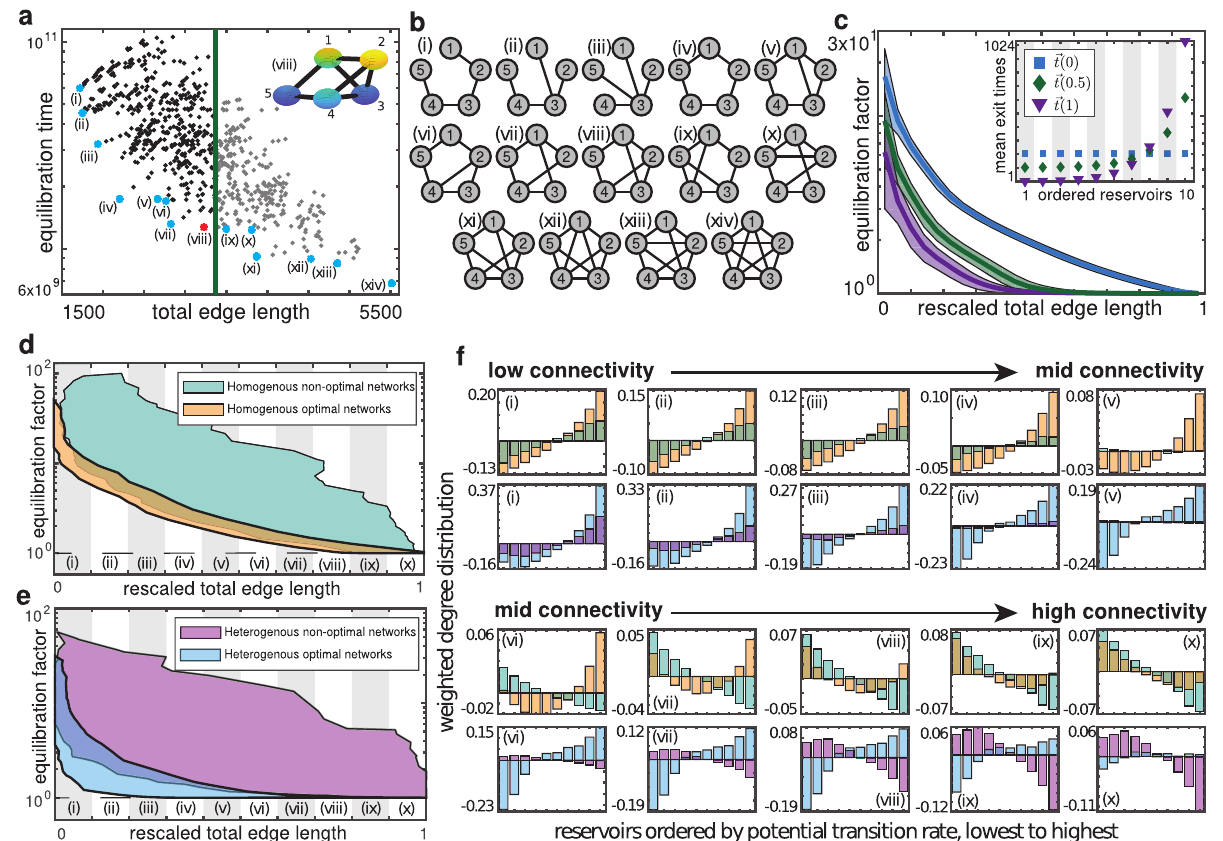
Fig. 3 Optimal topologies that minimise networked equilibration times. a Equilibration time and total edge length for all 728 connected topologies for a con fi guration of fi ve reservoirs (inset). The reservoir colours represent the change in elevation highlighting how they are positioned in three-dimensional space. The optimal frontier is highlighted in asterisks and given labels (i) – (xiv). For a given restriction (vertical line) the optimal network is given by label (viii) and the asterisk is red. b Topologies of the networks that lie on the optimal frontier in panel ( a ). c Averaged coordinates from numerically estimated optimal frontiers (Supplementary Note 4) with increasing levels of reservoir heterogeneity. The vectors of reservoir mean exit times are t (0), t (0.5) and t (1) (inset). The shaded regions represent the standard deviation either side of the mean. d The range of equilibration factors of both optimal and non- optimal networks for homogeneous, t (0), and heterogeneous, t (1), reservoir geometries. The shaded regions outlines the boundary of a point cloud from 5000 different con fi gurations of 10 reservoirs (Supplementary Note 4), both optimal and non-optimal. e The range of equilibration factors of both optimal and non-optimal networks for heterogeneous, t (1), reservoir geometries. The shaded regions outlines the boundary of a point cloud from 5000 different con fi gurations of 10 reservoirs (Supplementary Note 4), both optimal and non-optimal. f The bar charts (i) – (x) show the weighted degree distribution for both optimal and non-optimal networks across the range of rescaled total edge lengths. The heterogeneous vector of reservoir mean exit times used in ( c ) (cid:4) (cid:5) and ( f ) is τ ¼ 2 1 ; 2 2 ; ¼ ; 2 10 . All data presented in ( c ) – ( f ) uses the same 5000 con fi gurations of 10 reservoirs with randomly generated ensembles of narrow channel lengths K (Supplementary Note